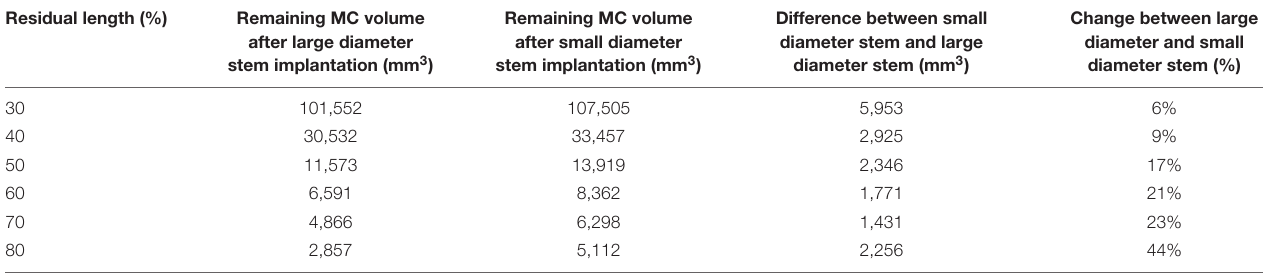
TABLE 6 | Volume of remaining medullary canal after virtual